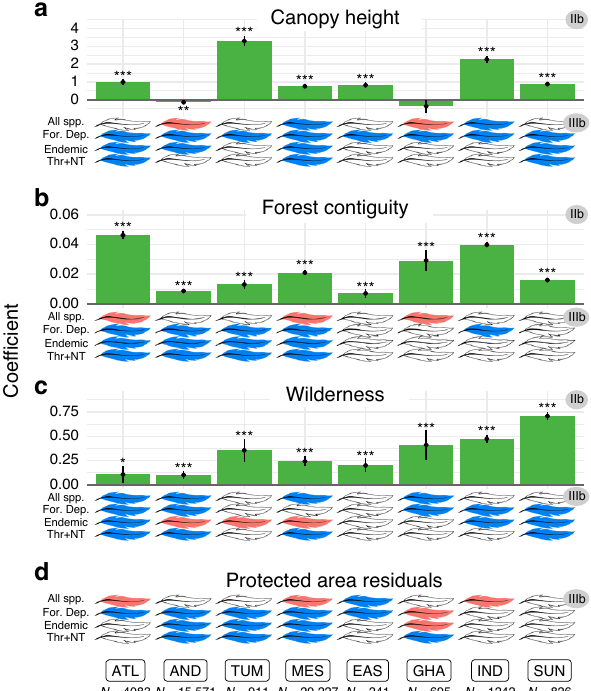
Fig. 5 Effects of protected areas on forest quality, and effects of forest quality on bird diversity, per hotspot. Bars: effects of protected areas on forest quality ( a canopy height; b forest contiguity; c wilderness; d protected area residuals; analysis IIb); coef fi cients correspond to the estimates of GAM models; signi fi cance given by P value (***<0.001 < **<0.01 < *<0.05), and 95% con fi dence interval around GAM coef fi cients (vertical error bars). Feathers: colour represents the effect sign (blue: positive; red: negative; white: non-signi fi cant [ P value > 0.05]) of each habitat quality variable on each of the bird diversity variables (All